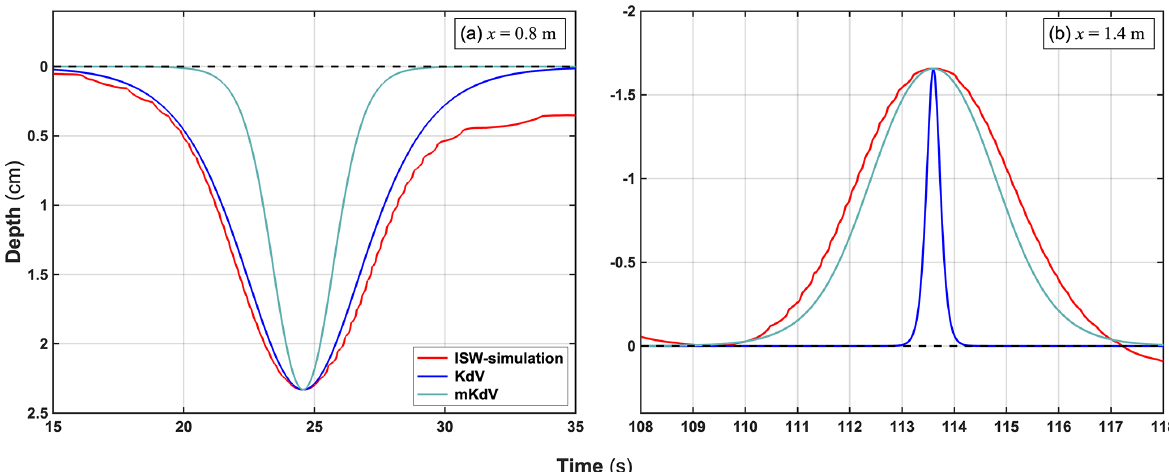
Figure 12. Wave profiles at x = 0 . 8 (a) and 1.4m (b) . The left (right) refers to the depression (elevation) heading wave before shoaling (deepening); the results are plotted with the red line. The blue and cyan lines represent the KdV and m-KdV model results.